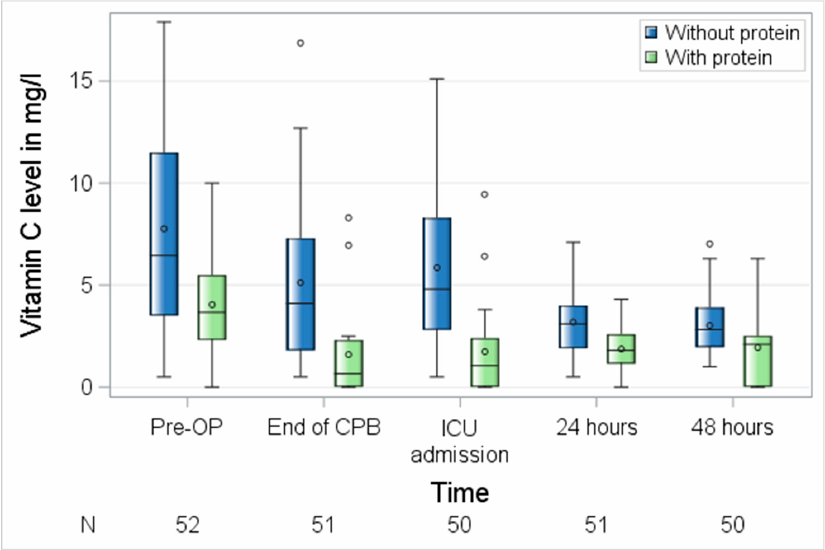
Figure 3. Perioperative course of vitamin C with different probe handling. CPB, cardiopulmonary bypass; ICU, intensive care unit; N, number of patients. Circles represent outliers.